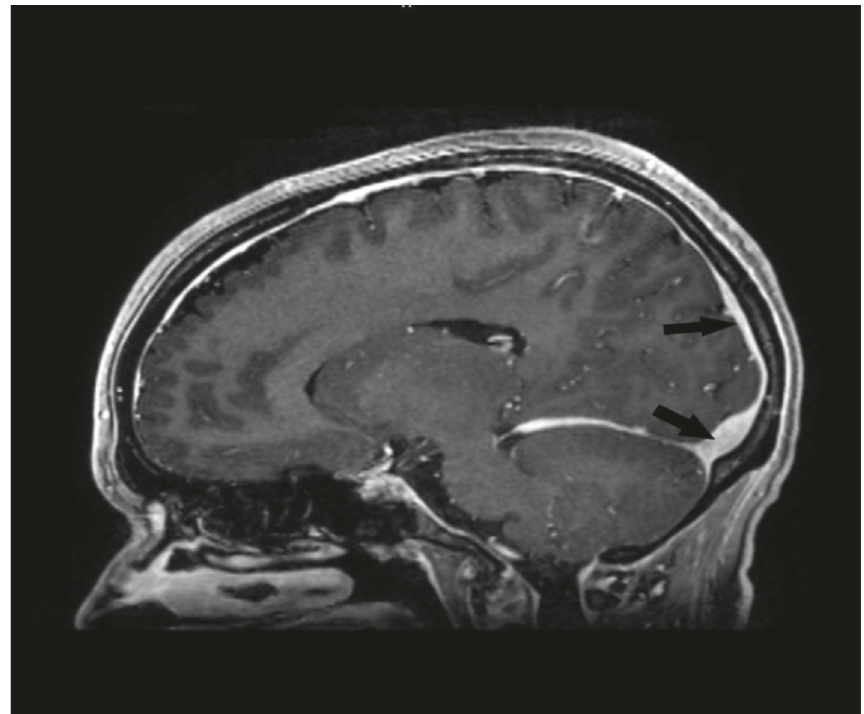
Figure 3: Magnetic resonance imaging (MRI) of the brain with contrast, postcontrast sagittal view showing marked improvement in the previously seen filling defect in the superior sagittal sinus